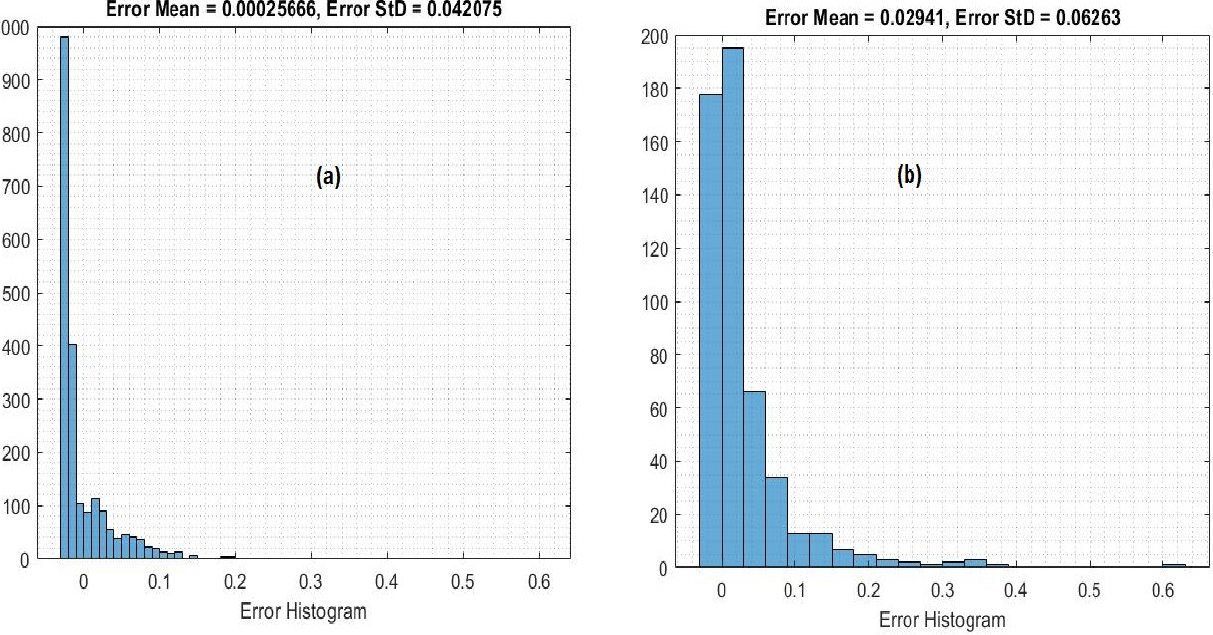
Figure 14. Time series plot of the LSTM model in predicting the prices of the XRP cryptocurrency. An error histogram of the LSTM model’s performance in predicting the future prices of the XRP cryptocurrency is presented in Figure 15. The mean error value of the prediction and target values of the LSTM model was 0.000256 in the training phase and 0.02941 in the testing phase.